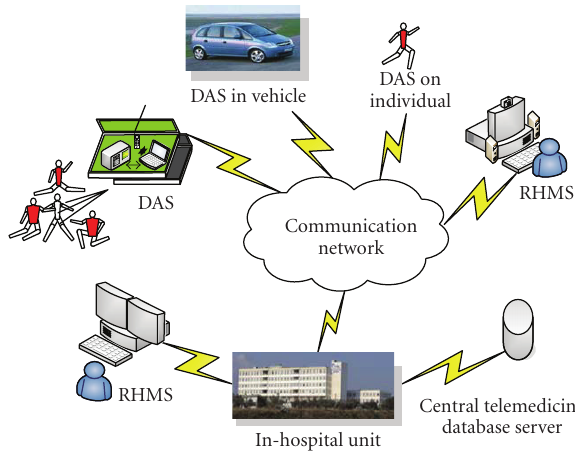
Figure 9: Structure of the designed Health Telemonitoring